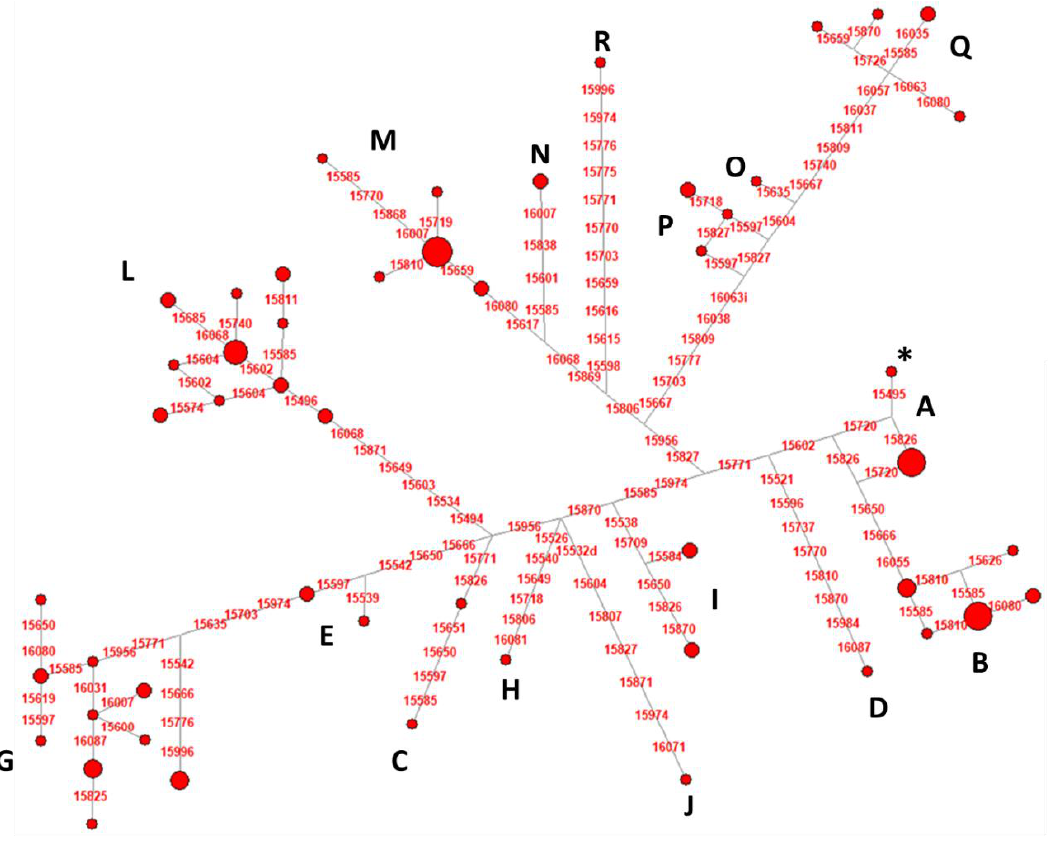
Figure 4. Median-joining network based on the control-region sequences (nps 15,491–16,100) of 92 Maremmano samples. The asterisk indicates the haplotype identical to ERS (Equine Reference Sequence; NC_001640.1). The figure shows the genetic relationship between haplotypes where each SNP indicates a single mutational event; each red circle is proportional to the number of samples carrying the same haplotype, and haplogroups are indicated with capital letters (see Table S2 for more details).